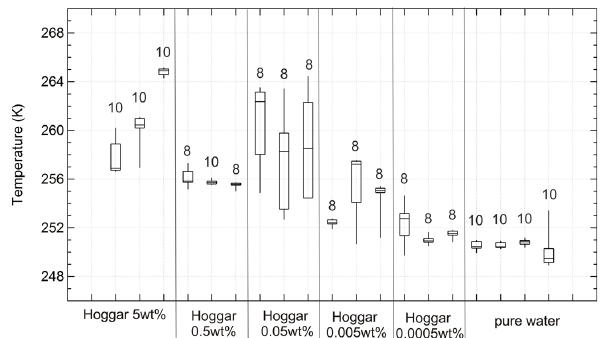
Fig. 10. Box and whisker plot of bulk measurements of Hoggar dust suspensions with different wt%. The numbers on each box represent the number of cycles.